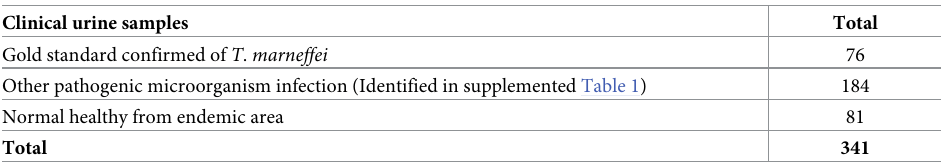
Table 2. Clinical urine samples used in the present study. Clinical urine